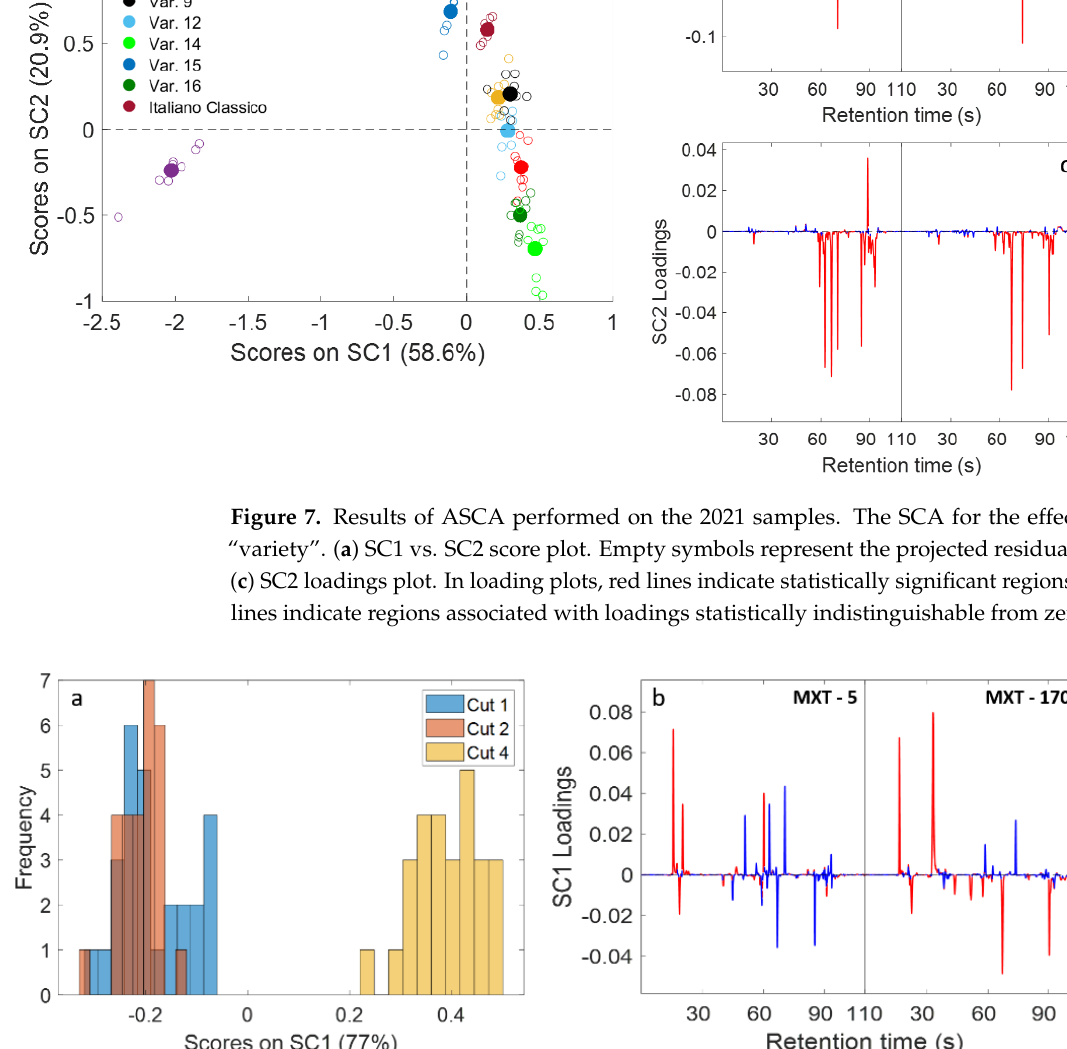
Figure 8. Results of ASCA performed on 2021 samples. The SCA for the effect of the factor “cut”. ( a ) histograms of ASCA score frequency (with projected residuals) on SC1 for the different levels of factor “cut”; ( b ) SC1 Loadings plot. In loading plots, red lines indicate statistically significant regions, whereas blue lines indicate regions associated with loadings statistically indistinguishable from zero.